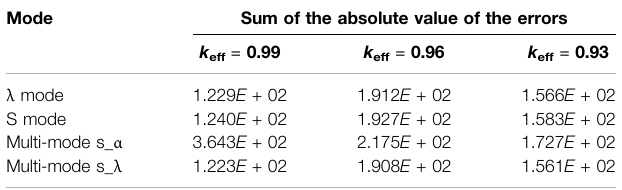
TABLE6| SumofthedeviationsbetweentheIQSandreferenceresultsduringthe entire beam transients.